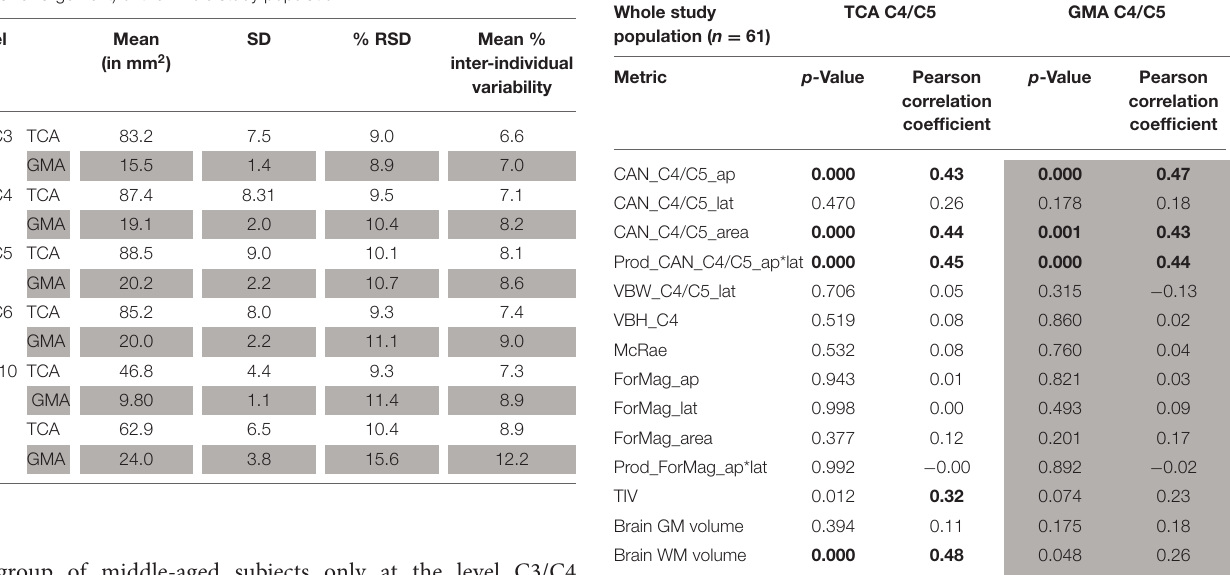
TABLE 1 | Mean % inter-individual variability, mean, SD and % RSD (% relative SD) of spinal cord total cross-sectional areas (TCA) and gray matter areas (GMA) at the intervertebral disc levels C2/C3–C5/C6, T9/T10, and T max (level of the lumbar enlargement) of the whole study population.